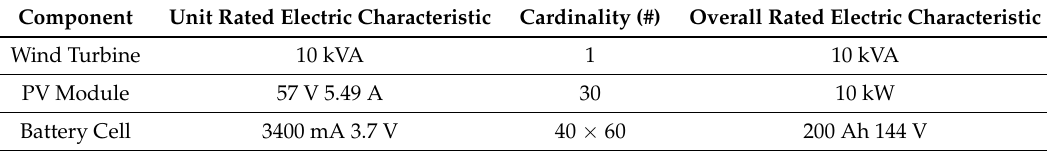
Table 1. Characteristics of prototype EES components.